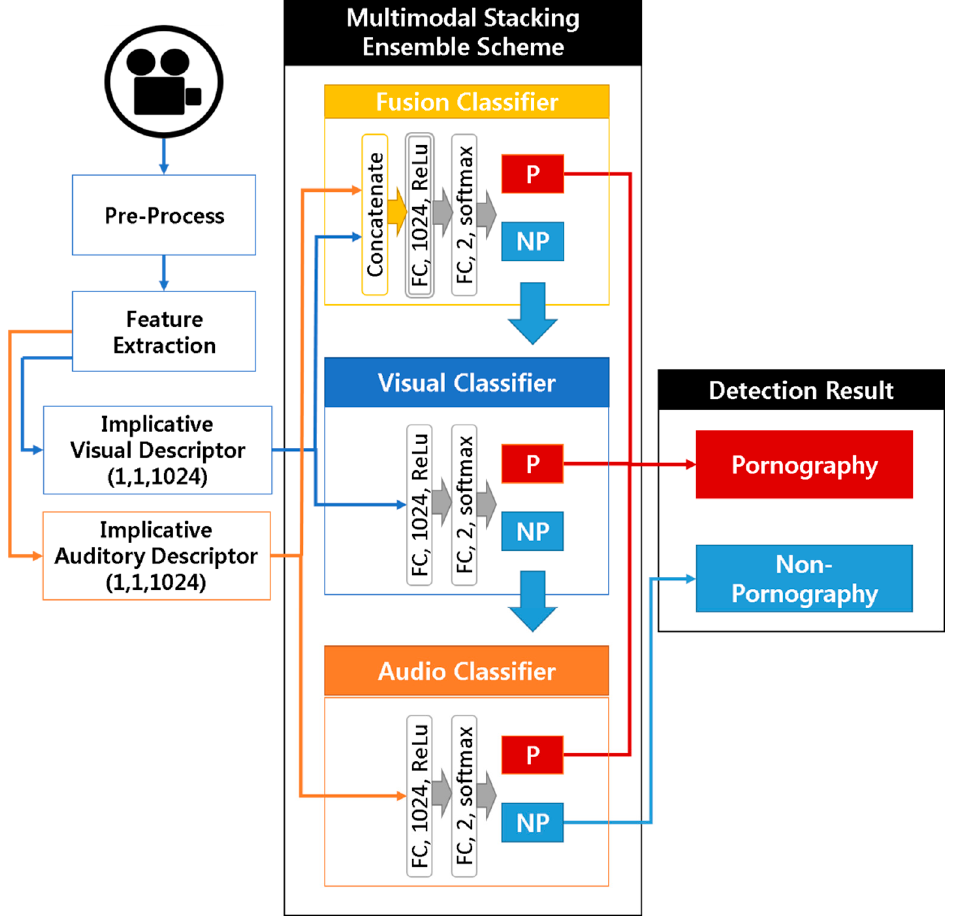
Figure 3. Pornographic detection with the proposed multimodal stacking ensemble scheme.